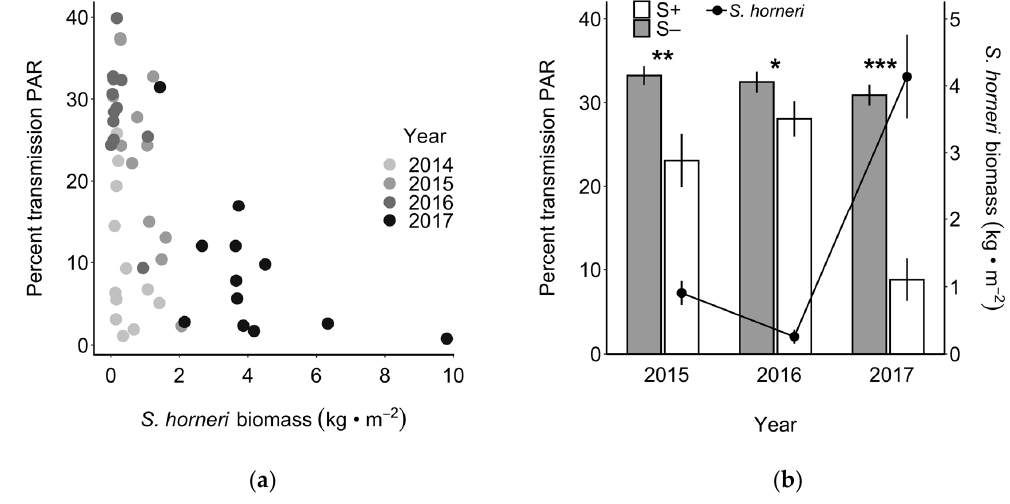
Figure 3. Percent transmission (i.e., percent of surface light reaching the bottom) of photosynthetically active radiation (PAR, 400–700 nm) related to Sargassum horneri biomass during spring. ( a ) Percent transmission of PAR related to S. horneri biomass in non-removal (S + ) plots only, with each sampling year indicated by a di ff erent shade. ( b ) E ff ect of S. horneri removal on PAR. The left y-axis shows percent transmission of PAR (mean ± SE) in S. horneri -removal (S–; grey bars) and non-removal (S + ; white bars) plots, and the right y-axis shows damp biomass of S. horneri ( ± SE) in non-removal (S + ) plots when light measurements were taken. Asterisks indicate sample dates where t -tests indicated significant di ff erences between treatments (*, **, ***: p < 0.05, 0.01, and 0.001,